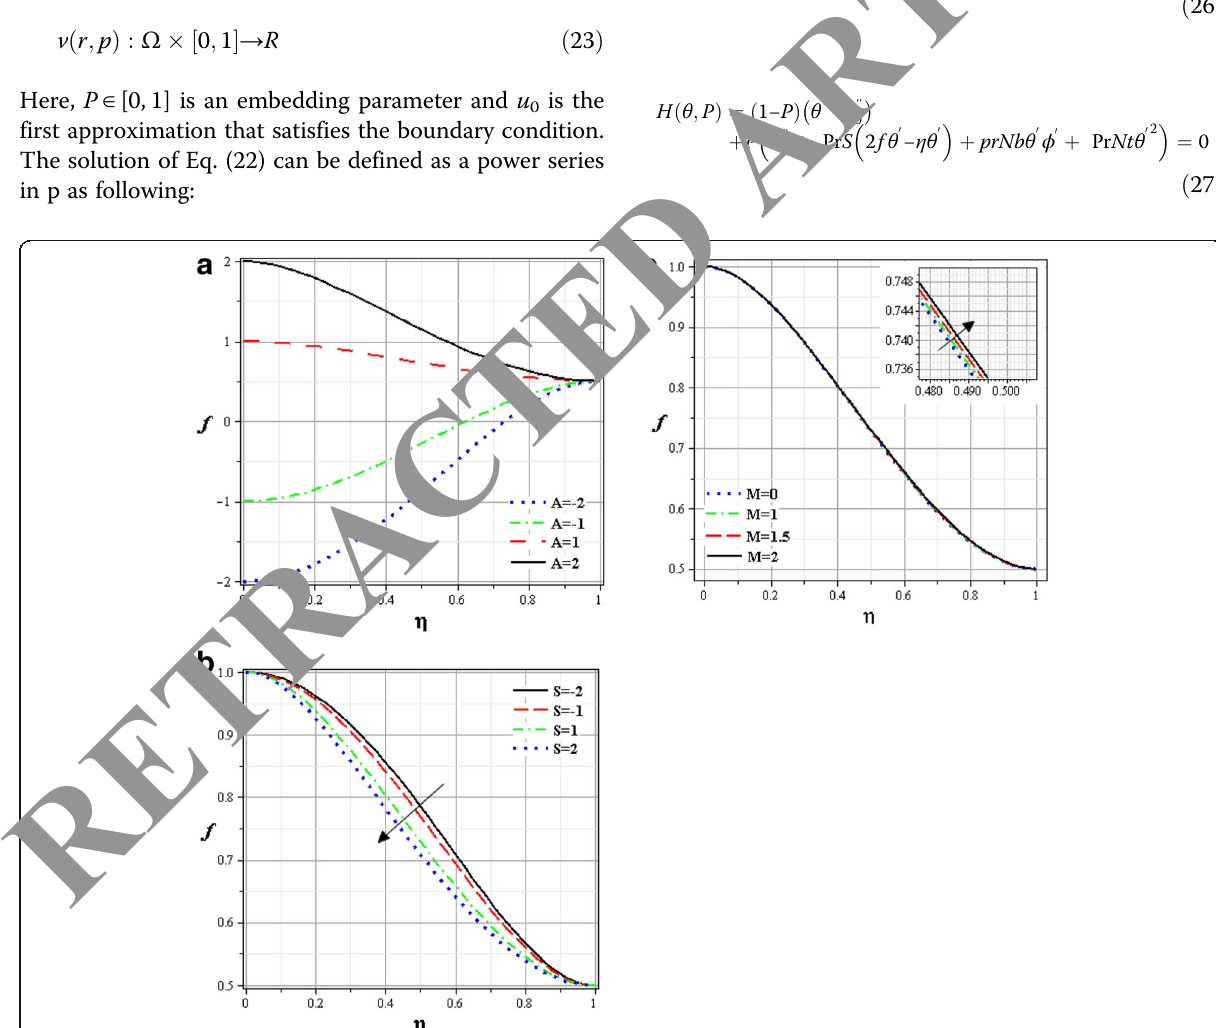
Fig. 3 a Effect of A parameter on velocity distribution when M = 1, S = 1, Le = 1, Nb = 1, Nt = 1, Pr = 6.2. b Effect of S parameter on velocity distribution when M = 1, A = 1, Le = 1, Nb = 1, Nt = 1, Pr = 6.2. c Effect of M parameter on velocity distribution when Nt = 1, A = 1, Le = 1, S = 1, Nb = 1, Pr =